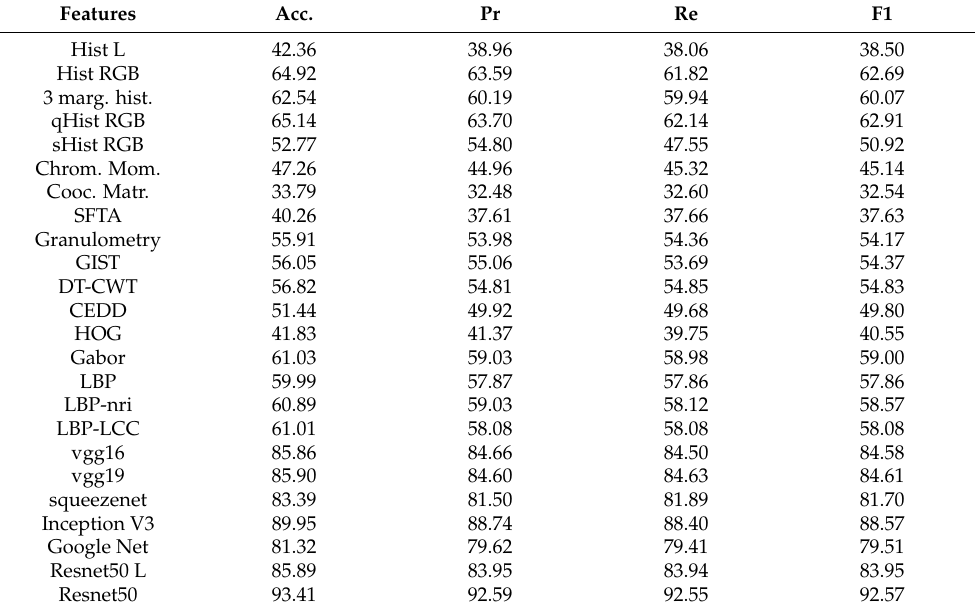
Table 4. Benchmark using 1-NN (5 classes).